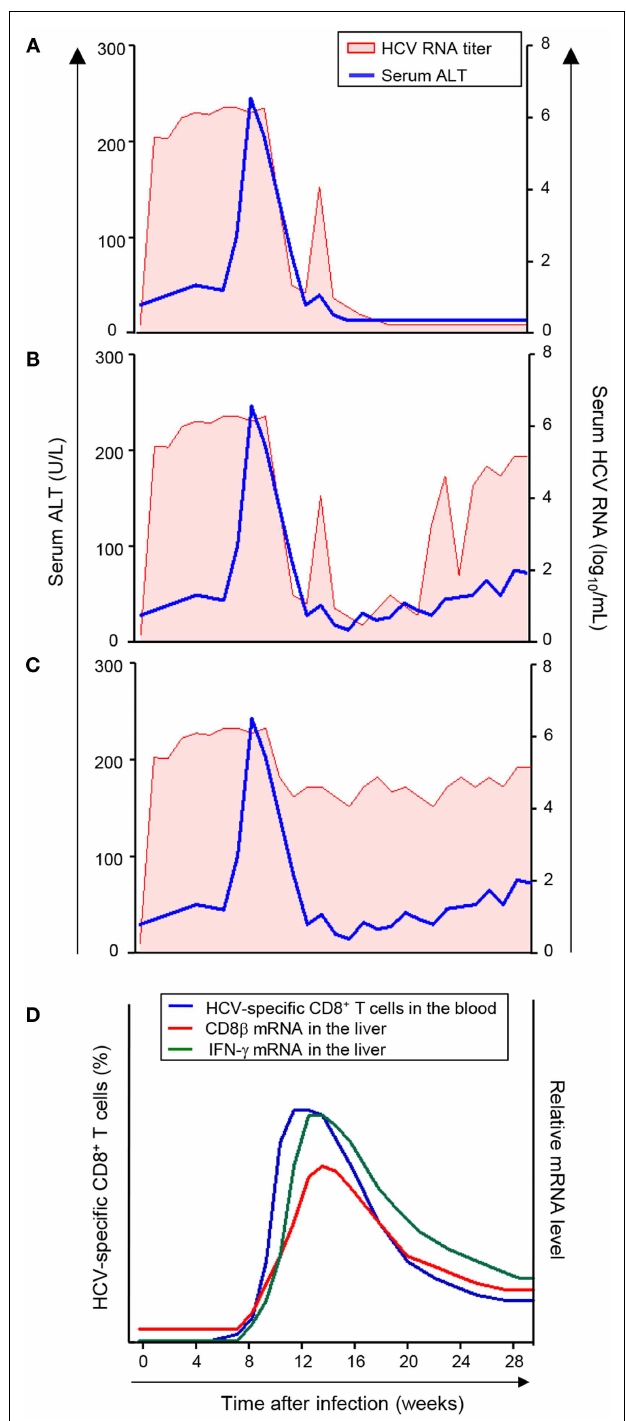
FIGURE 1 |Virologic courses and kinetics of CD8 + T-cell responses in acute HCV infection . (A–C) Three virologic patterns of acute HCV infection (11). (D) Kinetics of CD8 + T-cell response in acute HCV infection (20, 21). The frequency of HCV-specific CD8 + T-cells in the blood and mRNA levels of CD8 β and IFN- γ in the liver are presented.The appearance of HCV-specific CD8 + T-cells in the blood coincides with the increase in mRNA levels of CD8 β and IFN- γ in the liver and with serum ALT elevation and a decrease in HCV RNA